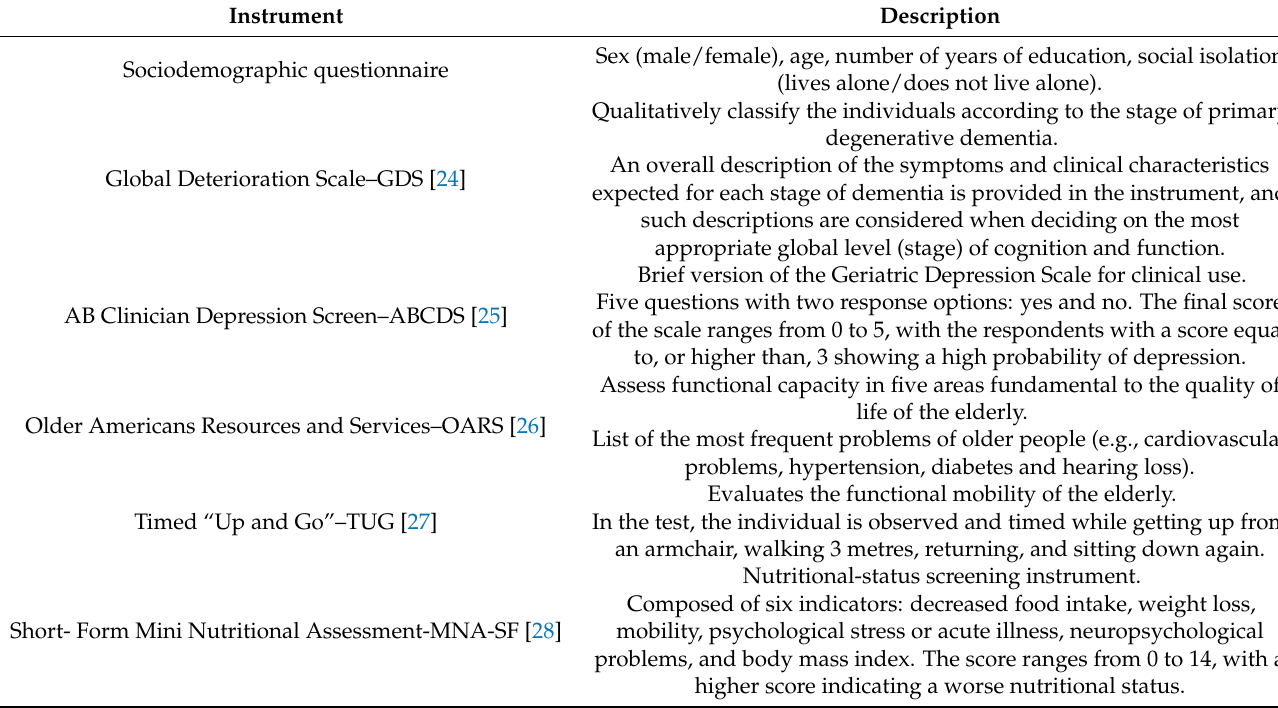
Table 1. Instruments included in the assessment